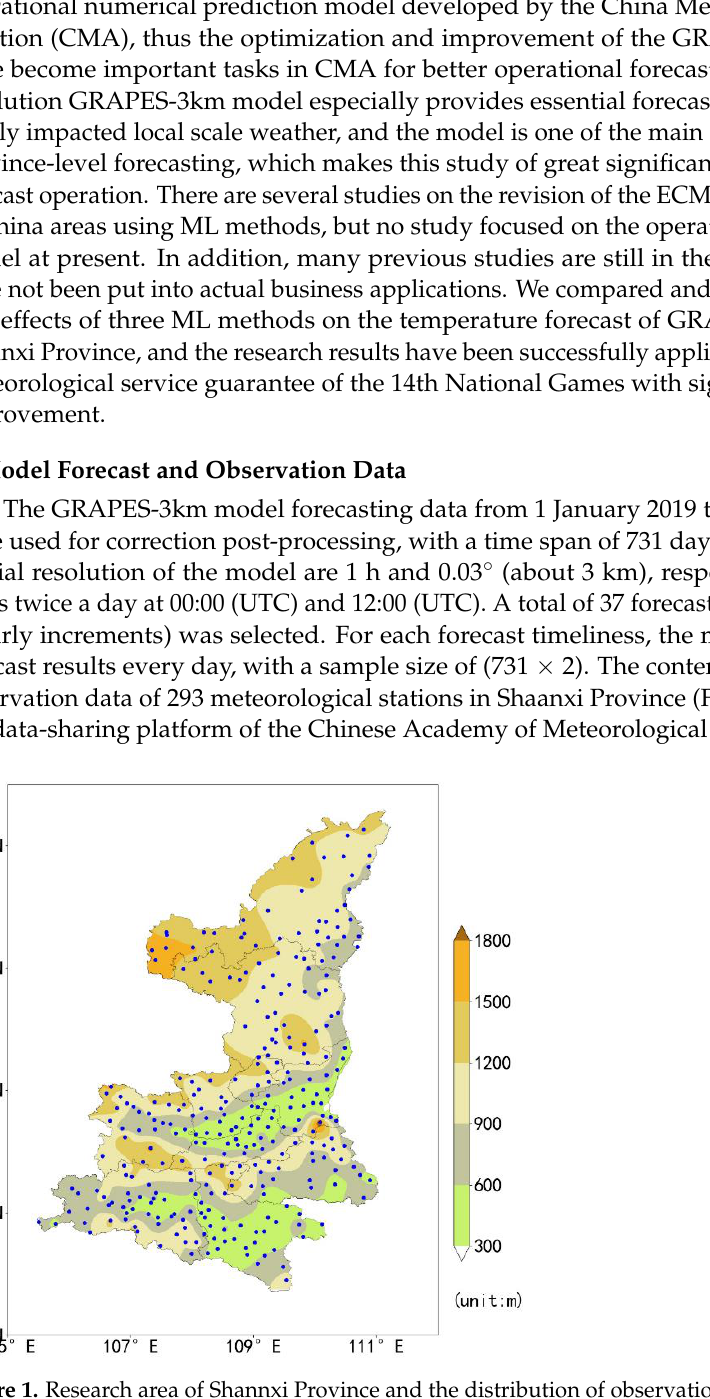
Figure 1. Research area of Shannxi Province and the distribution of observation stations. The shaded color represents the relief elevation.